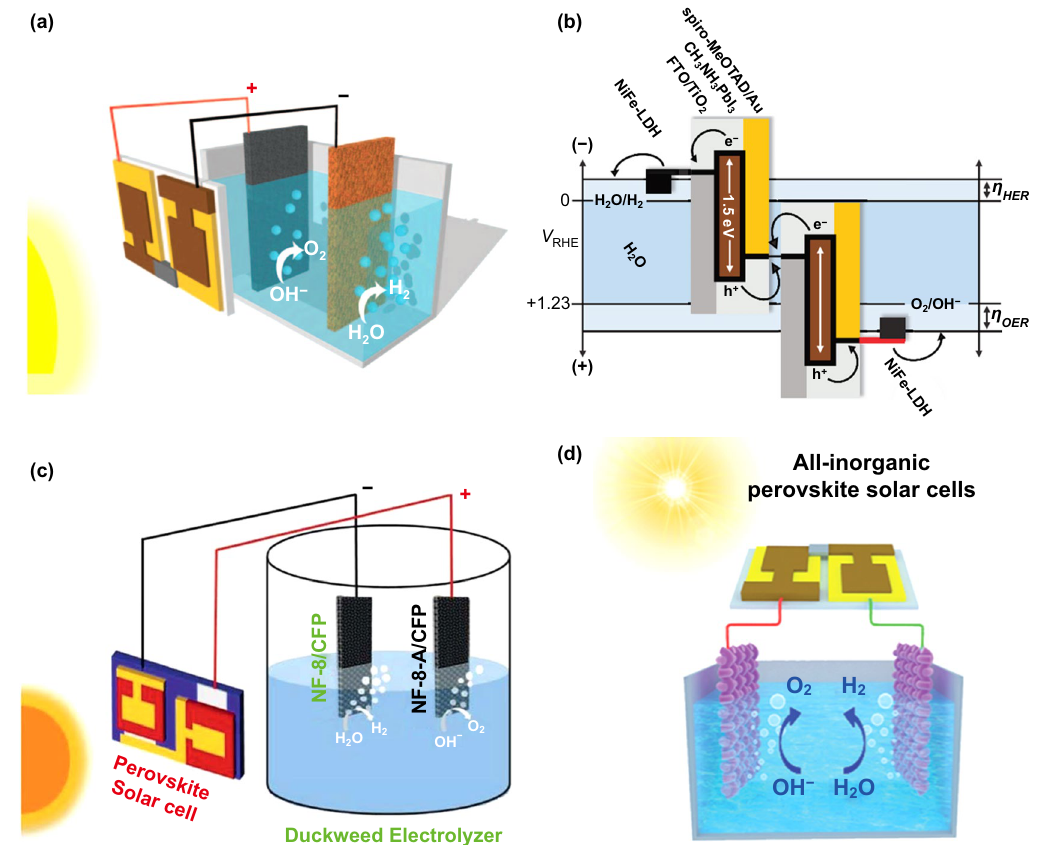
Fig. 10 a Schematic diagram and b a generalized energy of the tandem PSC for water splitting. Reproduced with permission from Ref. [140]. Copyright 2014 American Association for the Advancement of Science, c schematic diagram of the solar energy-driven overall water splitting device with a PSC. Reproduced with permission from Ref. [141]. Copyright 2018 Royal Society of Chemistry, d configuration of the electro- lyzer with the Ni 0.5 Co 0.5 P/CP bifunctional electrocatalyst and all-inorganic PSCs under irradiation. Reproduced with permission from Ref. [123]. Copyright 2018 Royal Society of